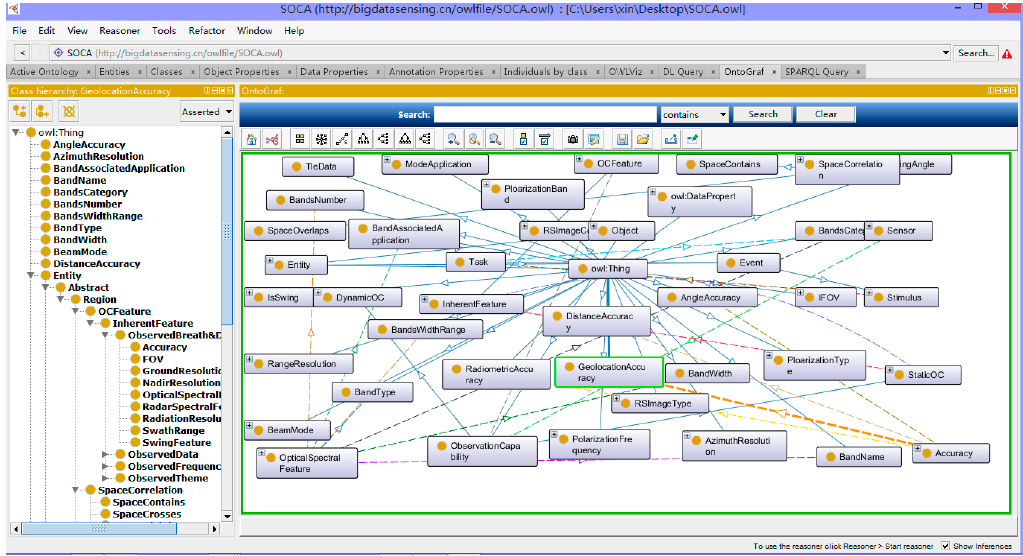
Figure 8. The graphical representation of sensor observation capability ontologies.